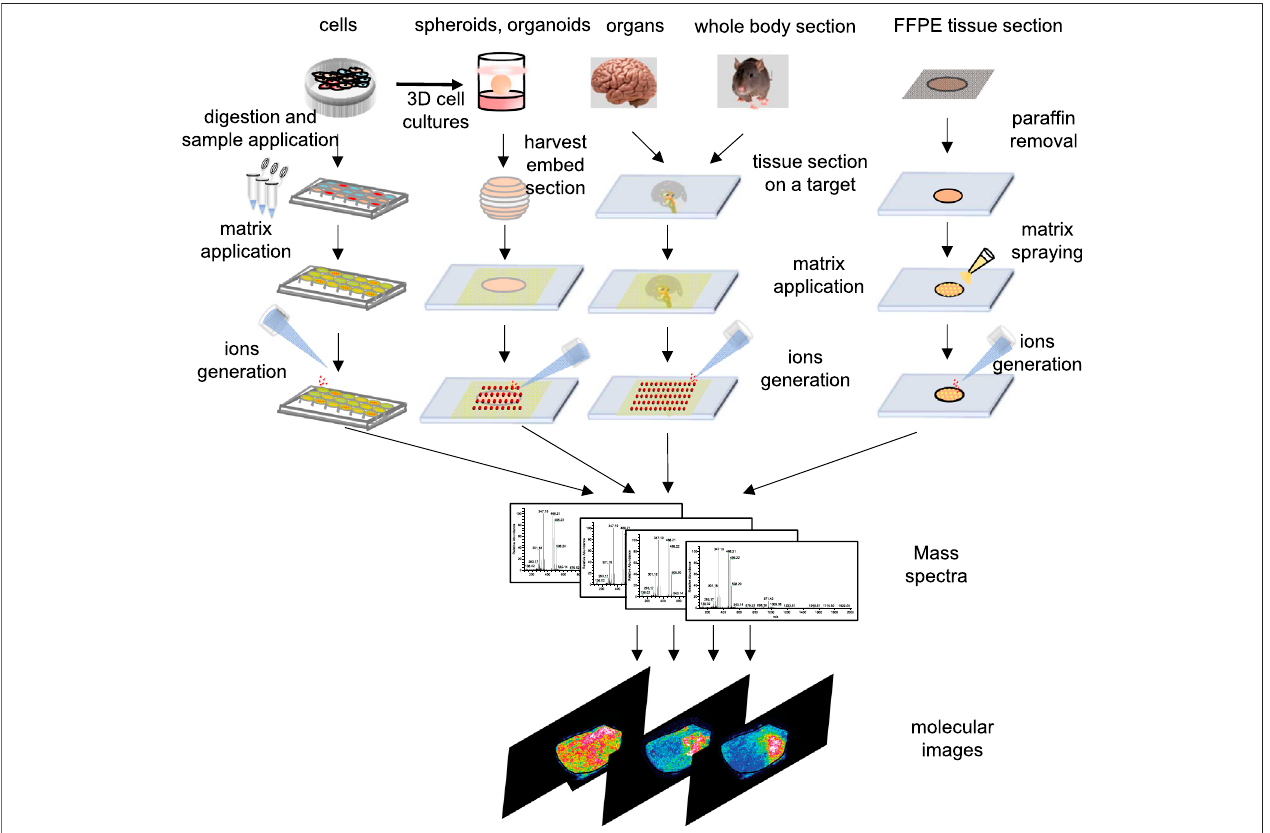
FIGURE 2 | Schematic outline of work fl ow of cells, spheroids, organ and tissue section, whole-body section and formalin- fi x, paraf fi n-embedded (FFPE) tissue section for an MSI experiment in different samples.